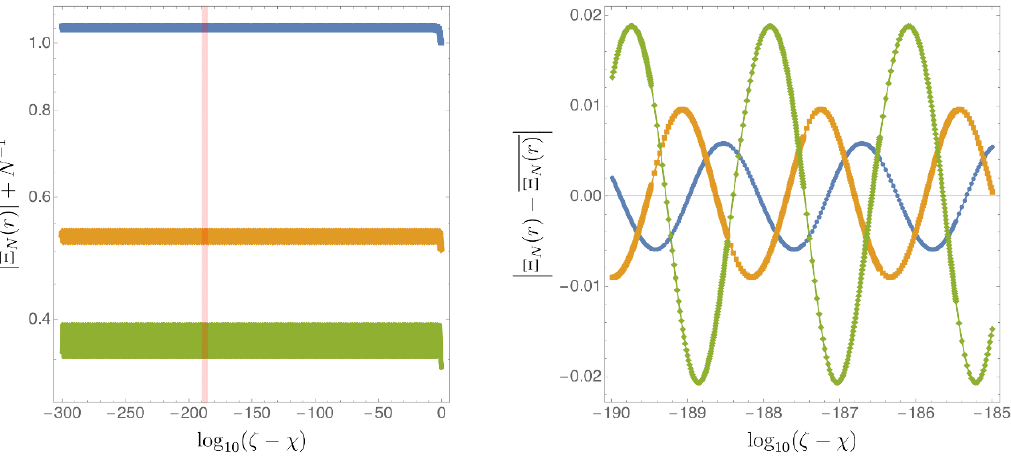
Figure 9 . Left panel: j (cid:4) N ( r ) j + N (cid:0) 1 , computed for several values of N , as a function of log The N (cid:0) 1 o(cid:11)set has been added to prevent the curves lying on top of each other. Right panel: (cid:12) (cid:12) (cid:12) (cid:12) (cid:4) N ( r ) (cid:0) (cid:4) N ( r ) in the region (cid:0) 190 < log ( (cid:16) (cid:0) (cid:31) ) < (cid:0) 185, corresponding to the red band on the (cid:12) (cid:12) 10 left panel. In both panels, the blue disks corresponds to N = 1, the orange squares to N = 2 and the green diamonds to N = 3. In all cases we we have (cid:11) = 2 (cid:25) and (cid:12) = 1 =